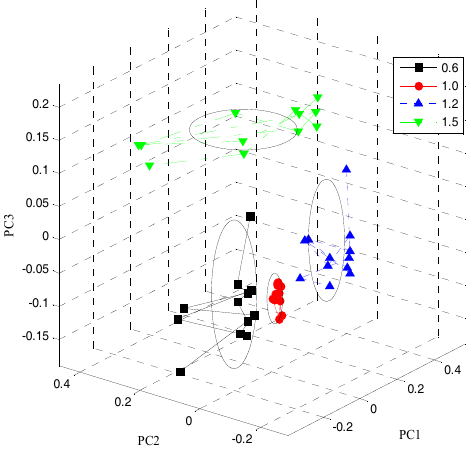
Figure 4. The PCA processing result.